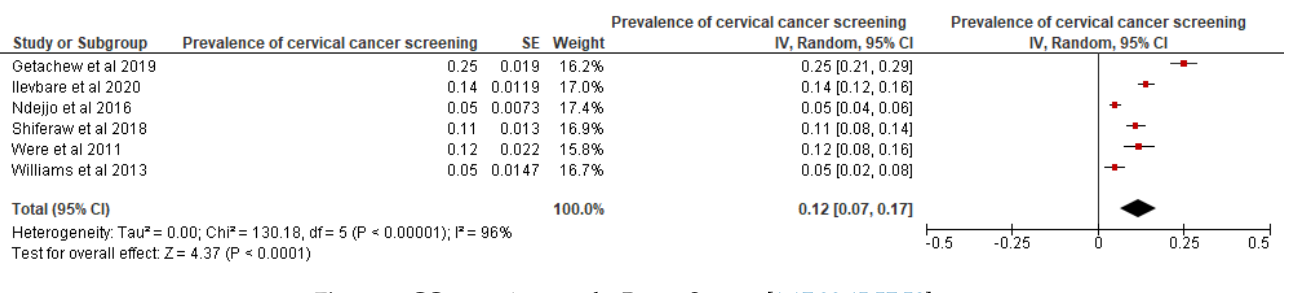
Figure 7. CC screening uptake Rates. Source: [1,17,38,45,57,58].